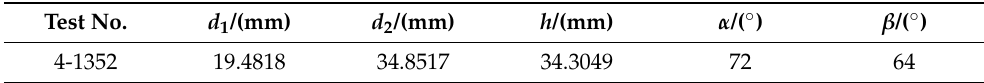
Table 5. Characteristic parameter data of debris clouds in Piekutowski’s test.